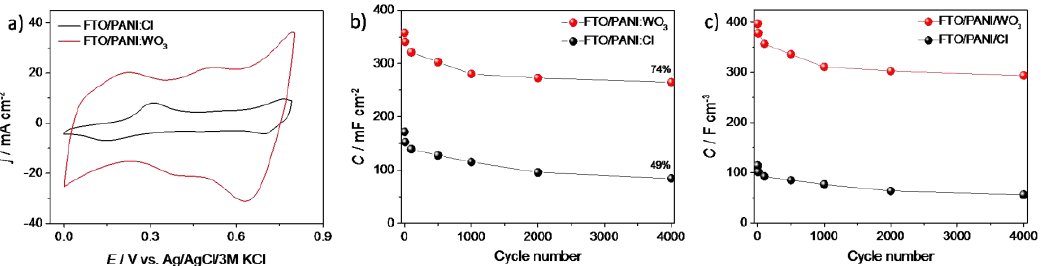
Figure 4. ( a ) The cyclic voltammetry curves of FTO / PANI / Cl and FTO / PANI / WO 3 in 1 M H 2 SO 4 , scan rate 50 mV s − 1 ; ( b ) the areal capacitance and ( c ) the volumetric capacitance vs. number of cycle plot for FTO / PANI / Cl and FTO / PANI / WO 3 electrode materials (charge / discharge current density 2 mA cm − 2 , polarized from 0 to 0.8 V vs. Ag / AgCl / 3 M KCl).